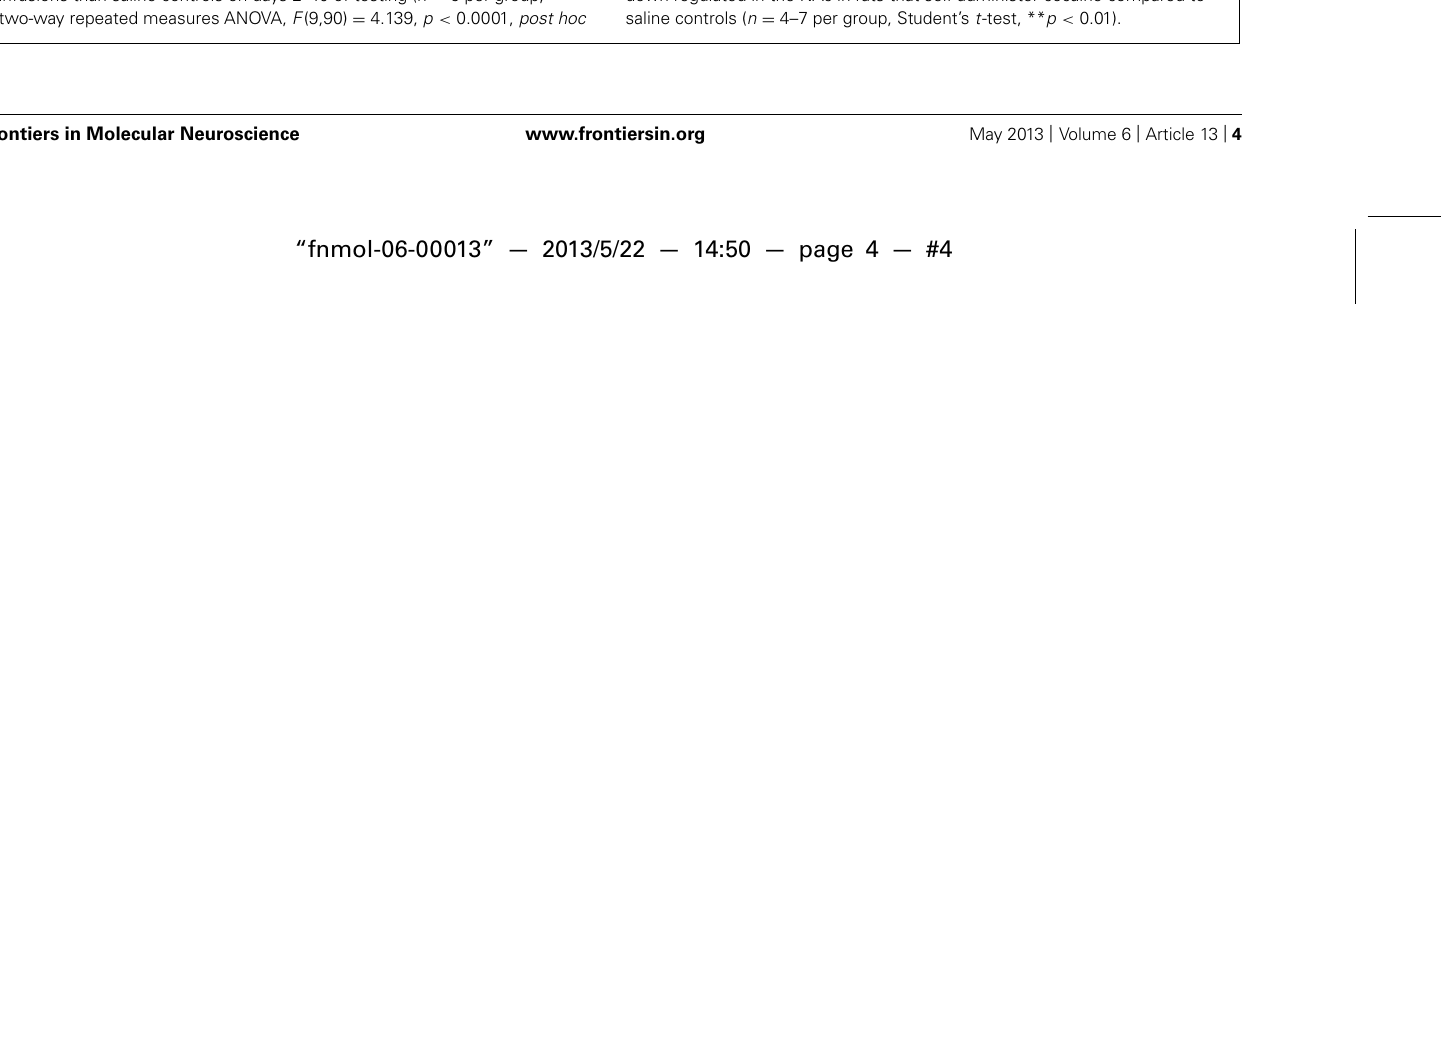
FIGURE 1 |Tiam1 is decreased in the NAc of rats that self-administer cocaine. (A) Self-administration of cocaine (1.0 mg/kg/infusion, FR1 schedule) or saline over a 10-day period. Rats self-administering cocaine took more infusions than saline controls on days 2–10 of testing ( n = 6 per group, two-way repeated measures ANOVA, F (9,90) = 4.139, p < 0.0001, post hoc